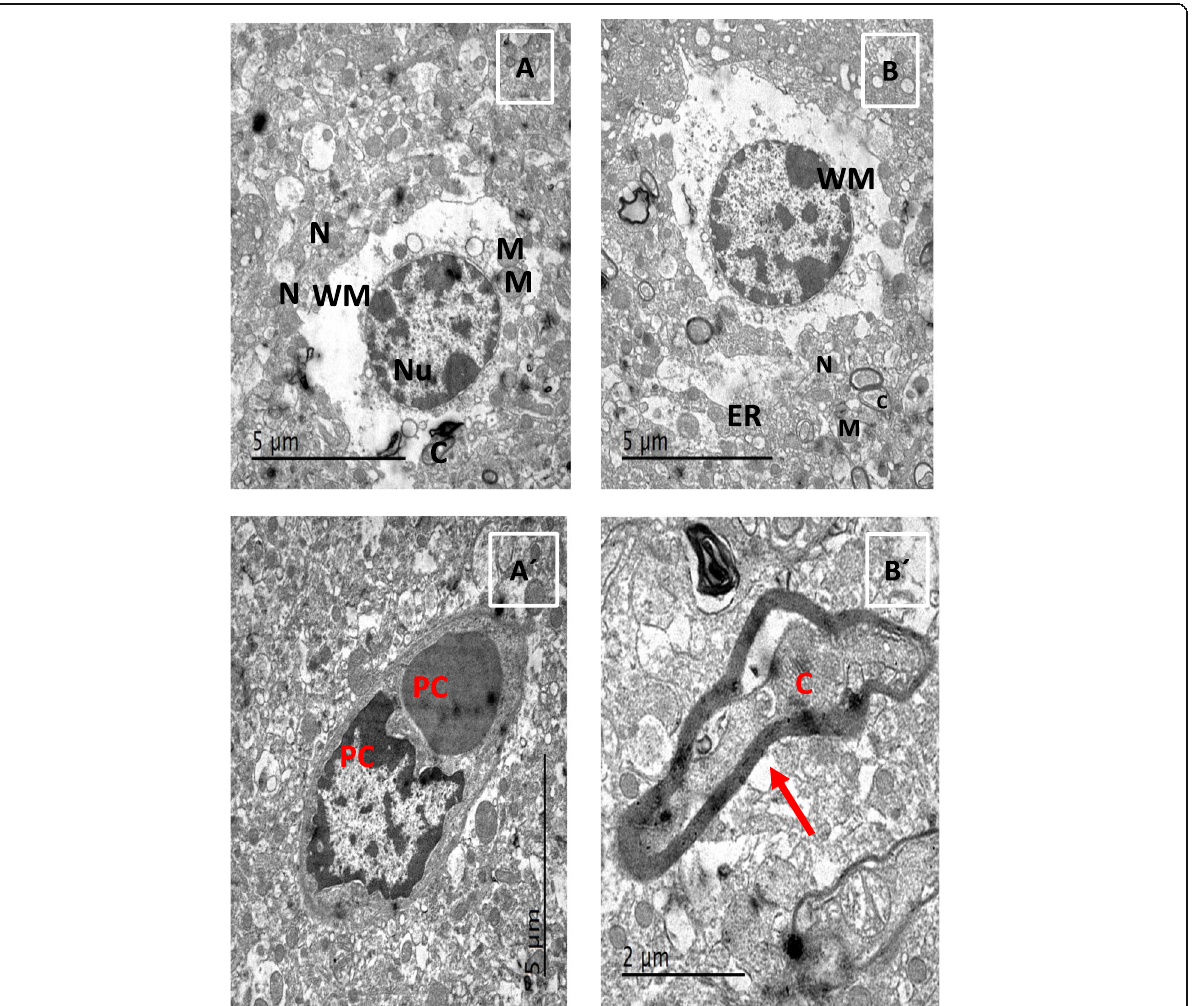
Fig. 6 Transmission electron microscope of brain section in control and LC groups. a Control group; normal appearance of white matter of the brain (WM) and normal nucleus (Nu) with homogenous distribution of the chromatin, normal size for mitochondria (M), well-defined neurons (N), and appearance of well-defined structure of Purkinje cells with well cytological structures (PC). b LC group showing normal appearance of WM and normal appearance of Nu with homogenous distribution of the chromatin and normal sized mitochondria (M) as well as neurons (N) and blood